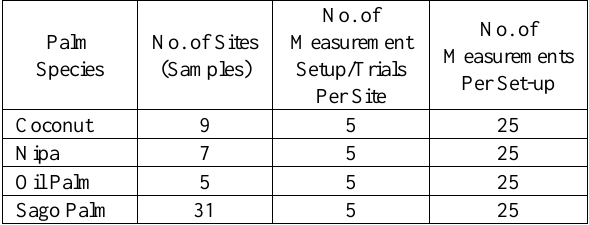
Table 1. Number of sampling sites for reflectance measurements.